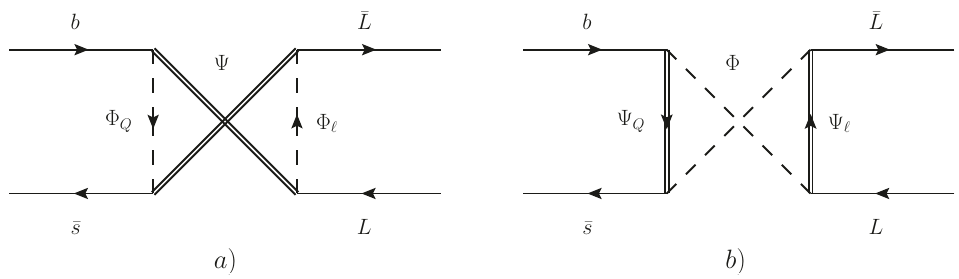
Figure 2 . Crossed boxes contributing to b ! s‘ + ‘ (cid:0) and b ! s(cid:23) (cid:22) (cid:23) in case a ) ( b )) if (cid:8) ((cid:9)) is a Majorana fermion (real